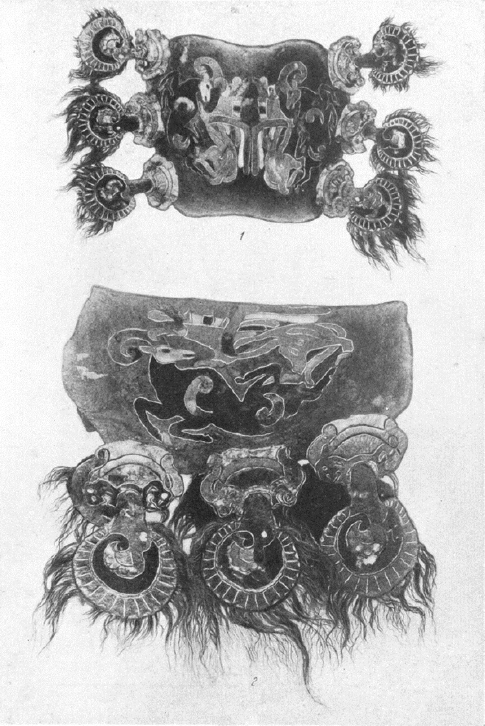
Figure 4. Saddle cover. Felt, leather, hair. Pazyryk, kurgan 1. (adapted from Rudenko 1953, Pl. 77).